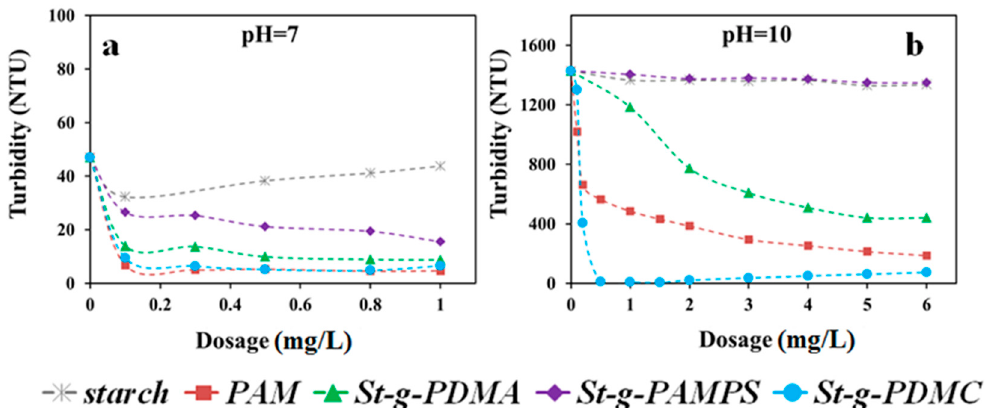
Figure 8. Turbidity versus dosage for the investigated polymer flocculants in Pioneer kaolin suspensions under ( a ) pH 7.0 and ( b ) pH